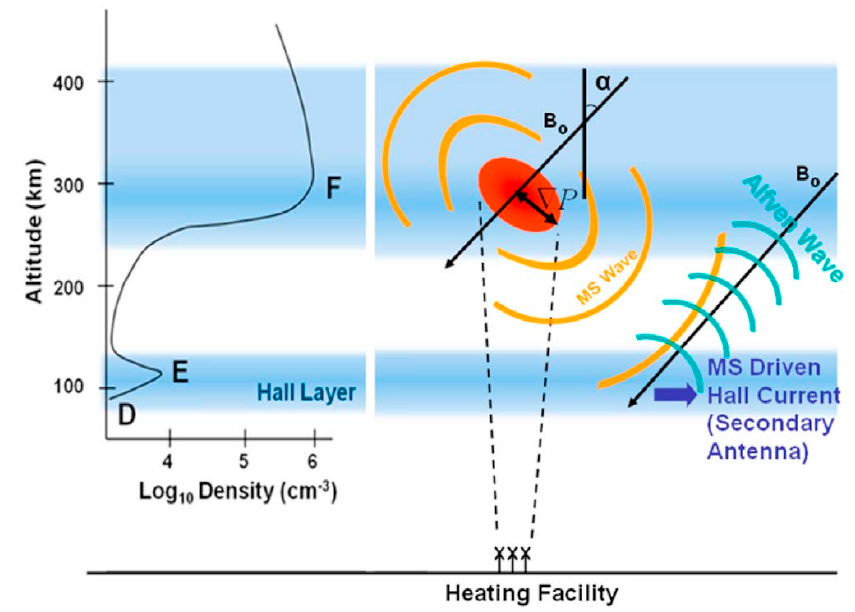
Figure 6. Schematic of the Ionospheric Current Drive (ICD) mechanism. Periodic heating of the F region leads to an oscillatory diamagnetic current and an associated field-aligned magnetic moment M that radiates isotropic Magneto-Sonic (MS) waves. Then, the MS waves drive the Hall current in the E region and couple them with Shear Alfvén Waves (SAW). The process injects ELF waves and SAW in the Earth-ionosphere waveguide and magnetosphere, respectively (reproduced with permission from Papadopoulos, K., Chang, C., Labenski, J., Wallace, T., First demonstration of HF-driven ionospheric currents; published by John Wiley and Sons, 2011 [66]).